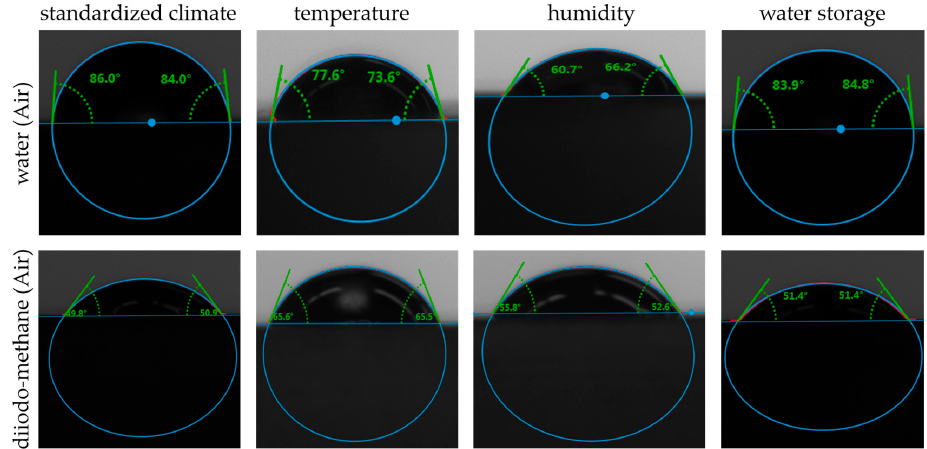
Figure 8. Water and diiodo-methane droplets of the contact angle